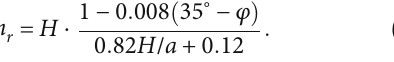
/ H (30 ° , 33 ° , 35 ° ) to h r